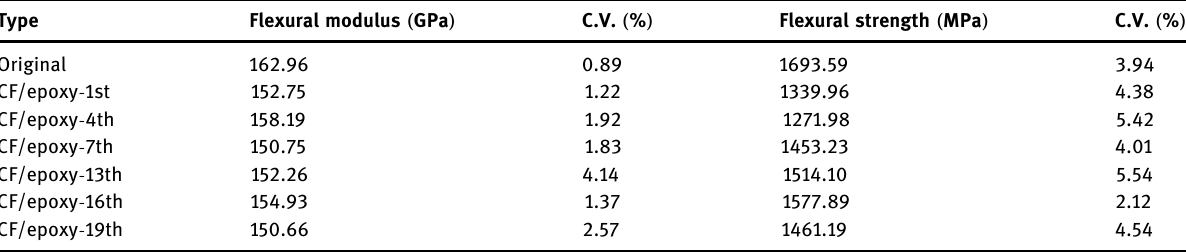
Table 1: Flexural mechanical properties of CF/epoxy laminates Type